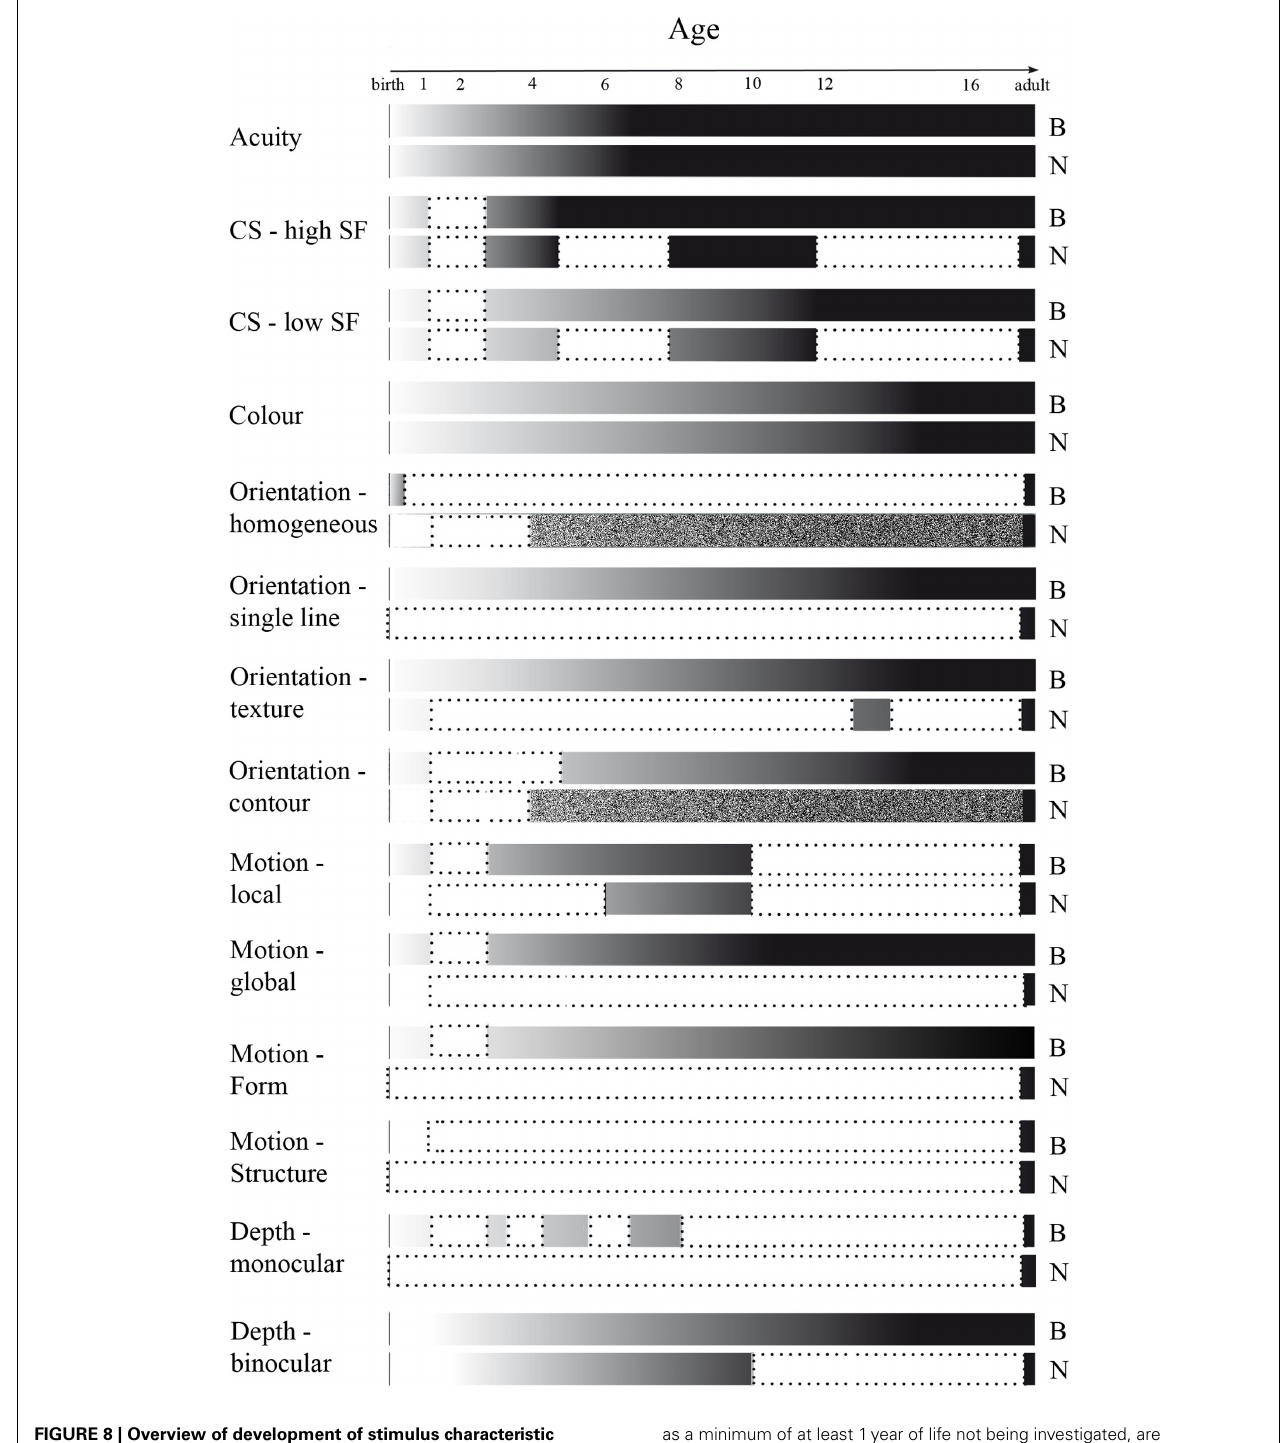
FIGURE 8 | Overview of development of stimulus characteristic processing, and of gaps in literature, as measured behaviorally (B) and neurophysiologically (N). Development depicted from infant (white) to adult-like (black) levels of processing. Literature gaps, defined